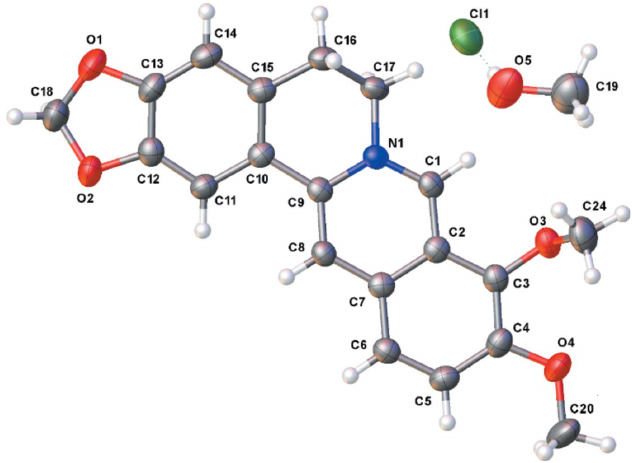
Figure 1 Molecular structure of the title compound with the atom labeling. Displacement ellipsoids are drawn at the 50% level.